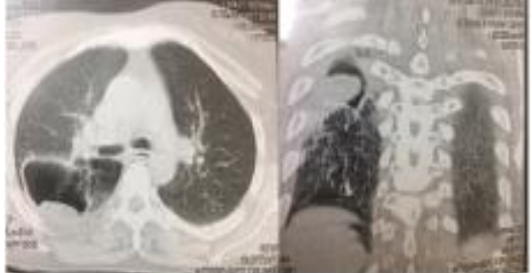
Figure 3: Chest CT revealed fungal ball inside